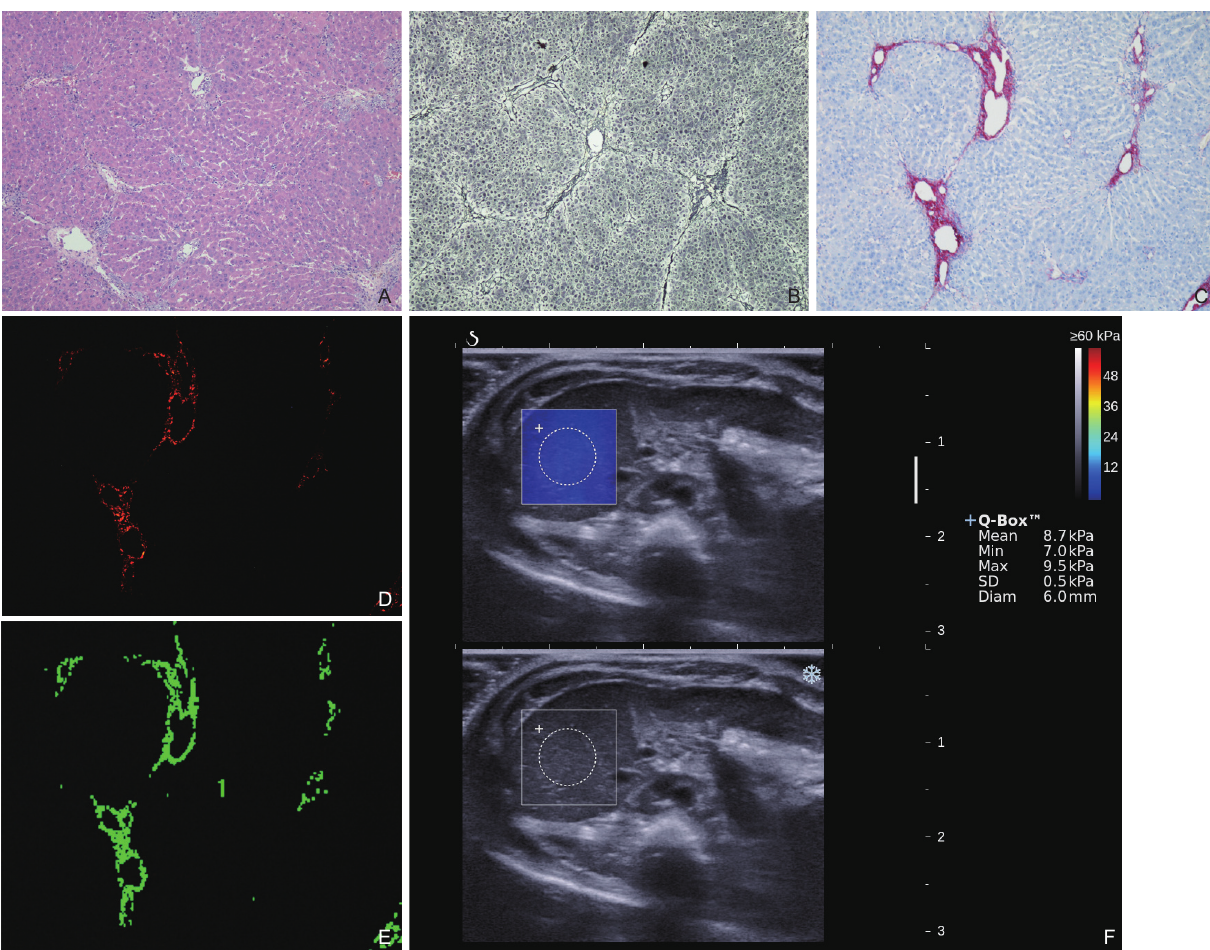
Figure 4 Image of rat ‘a’ histologically proven to be stage 3. HE staining (A) and reticular fiber staining (B) were used for the traditional scoring. Picric- sirius red staining (C), polarized imaging (D), and digital images (E) were used for collagen proportionate area (CPA) auto-calculation of 1.010. Elastogram (F) showed liver stiffness measured by shear wave elastography (SWE) to be 8.7